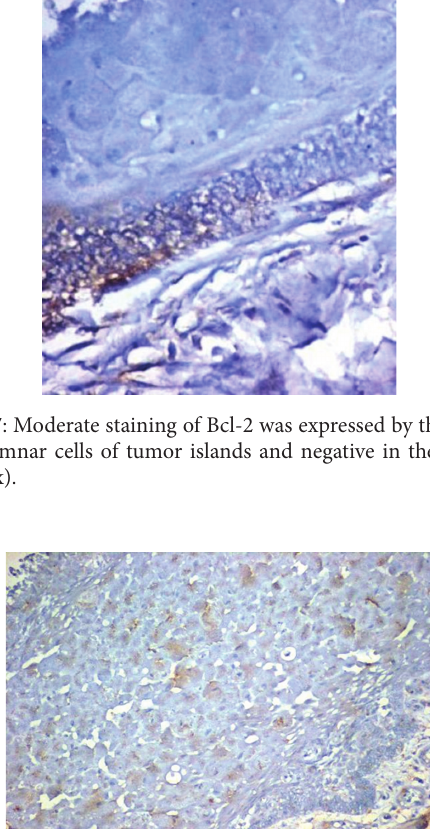
Figure5:Thegranularcellsexhibitedcoarselygranulareosinophilic cytoplasm and small pyknotic nuclei (H and E 40x).